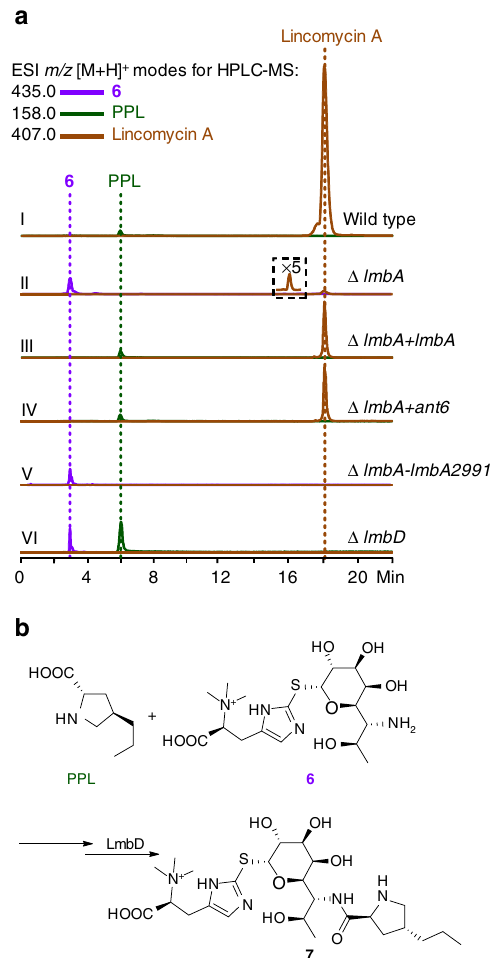
Figure 3 | In vivo functional characterization of lmbA and its orthologue lmbA2991 . ( a ) Product profiles of S. lincolnensis strains, including the wild-type control (I) and mutants (II, for the D lmbA single mutation; III, for homologous complementation of the D lmbA mutant by lmbA ; IV, for heterologous complementation of the D lmbA mutant by ant6 ; V, for D lmbA-lmbA2991 double mutation; VI, for the D lmbD single mutation). ( b ) The assembly of PPL and 6 that is mediated by a discrete NRPS system involving LmbD activity.